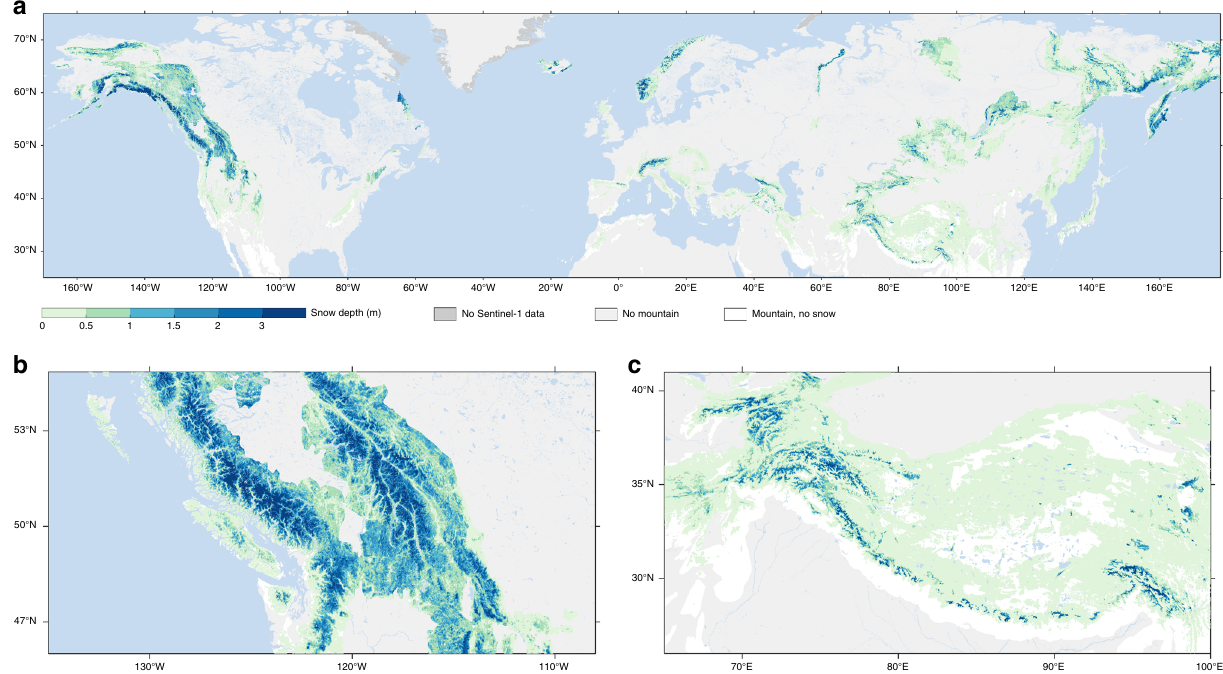
Fig. 4 Monthly snow depth retrieved by Sentinel-1. a Snow depth (m) over the Northern Hemisphere mountains. b Enlargement of a part of the western US and Canada. c As in panel b , but for a part of the Hindu-Kush Himalaya region. The ~weekly 1 km² resolution Sentinel-1 retrievals are averaged over the